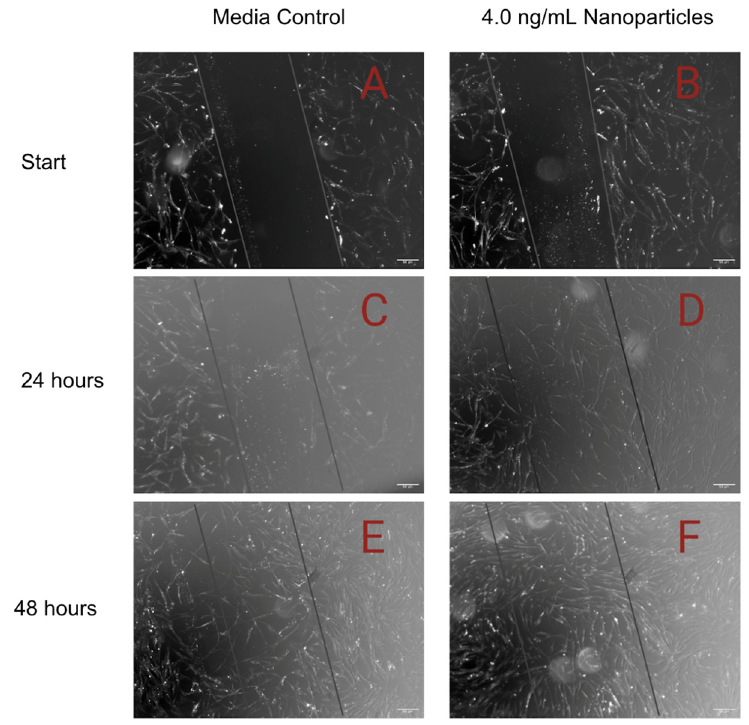
Figure 8. Scratch assay images of human lung fibroblasts. Confluent cell sheets were scratched and replenished with media [ left ] or 4.0 ng/mL of MMSC ECM nanoparticles [ right ]. The outline of the original scratch is superimposed on each image. Images obtained every 24 h. The scratch was closed at a faster rate with supplementation of nanoparticles. ( A ) Media, 0 h; ( B ) 4.0 ng/mL nanoparticles, 0 h; ( C ) media, 24 h; ( D ) 4.0 ng/mL nanoparticles, 24 h; ( E ) media, 48 h; ( F ) 4.0 ng/mL nanoparticles, 48 h. (magnification: 50 µ m).